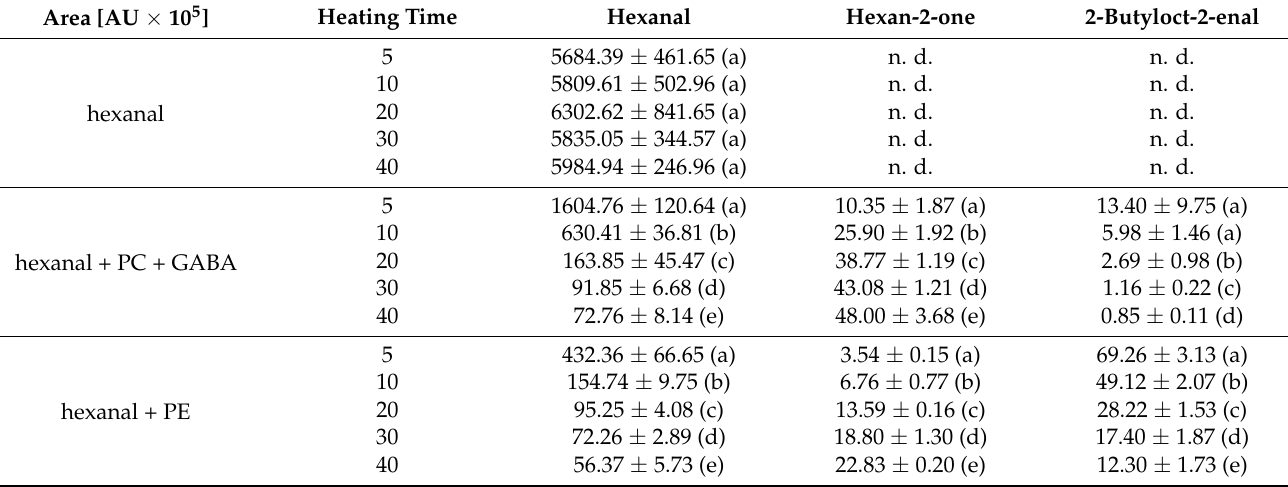
Table 5. Peak areas of hexanal, hexan-2-one, and 2-butyloct-2-enal from hexanal (0.05% in paraffin oil) without or with γ - amino butyric acid (GABA) (10 mg) + PC or PE, heated at 160 ◦ C for 40 min and analyzed by HS-GC-MS; n. d. = not detected. Area [AU × 10 5